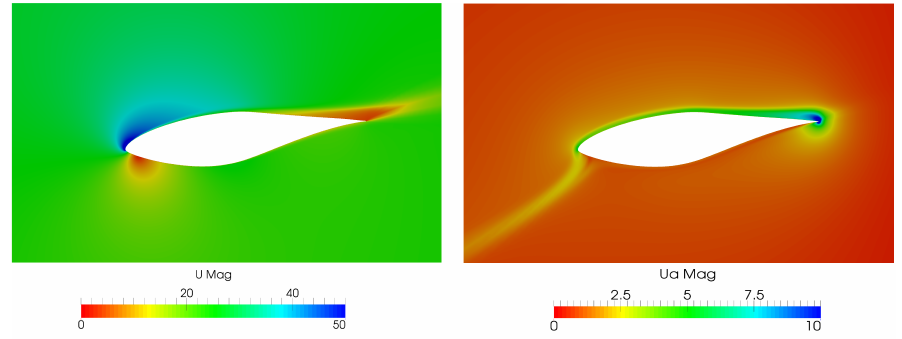
Figure 3. Magnitude (Mag) of the velocity U and adjoint velocity Ua around the blade at a cut at 3 m of the